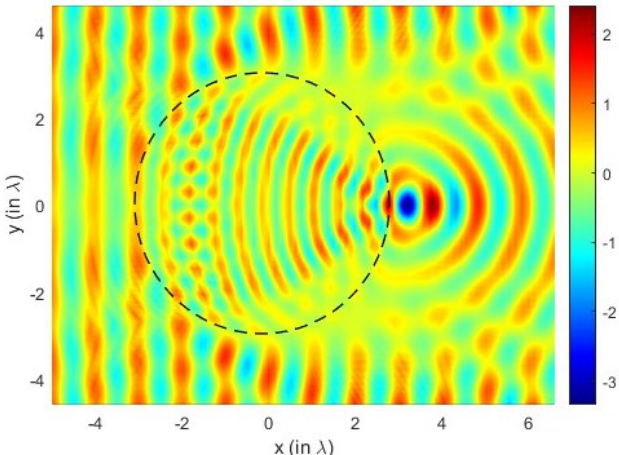
Figure 4. (Color online). Scattering on spheres with diameter: R = 3 and m =